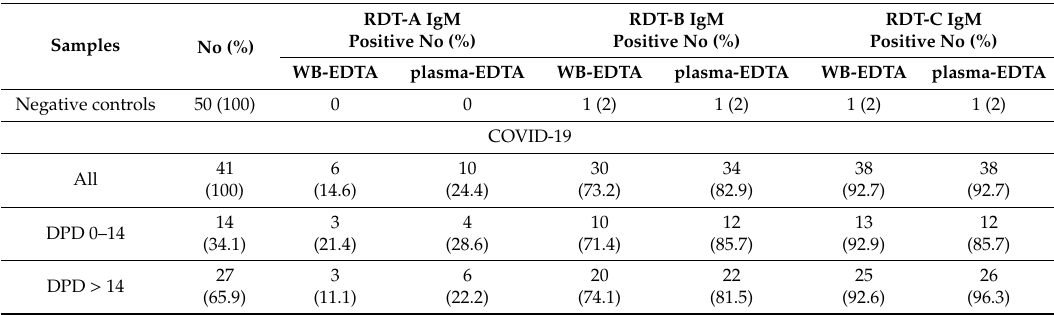
Table 5. SARS-CoV-2 IgM detection characteristics by various